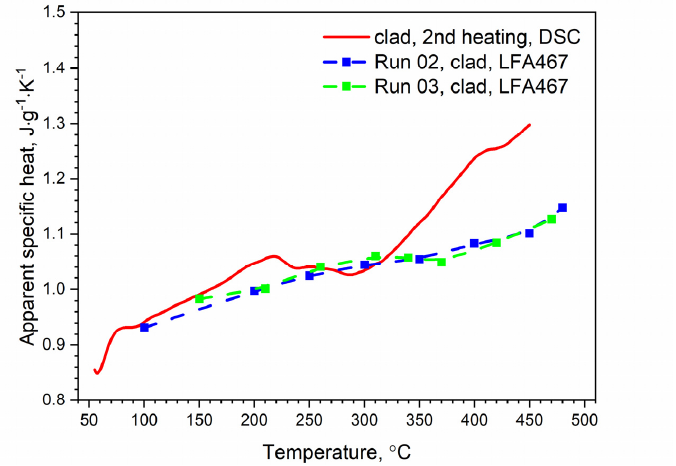
Figure 14. Comparison of the specific heat of the clad AW-2024-T3 alloy obtained from DSC (second heating run) and LFA measurements.